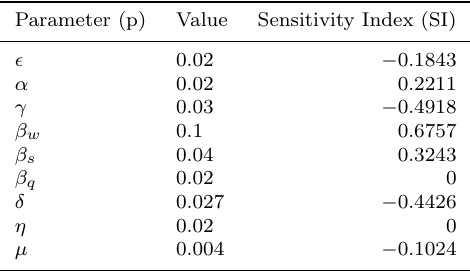
Table 2. The sensitivity indices of R q to any parameter p .